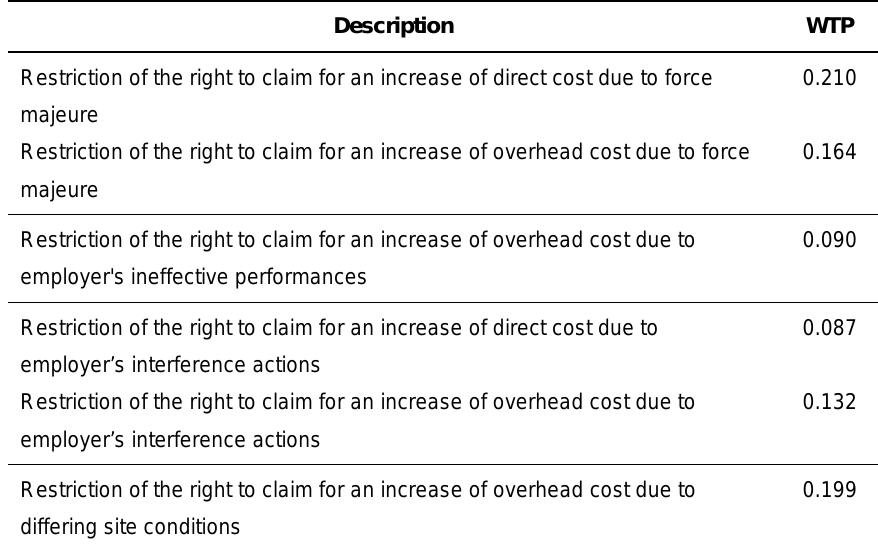
Table 5: Willingness of Thai government organizations to pay for the restriction